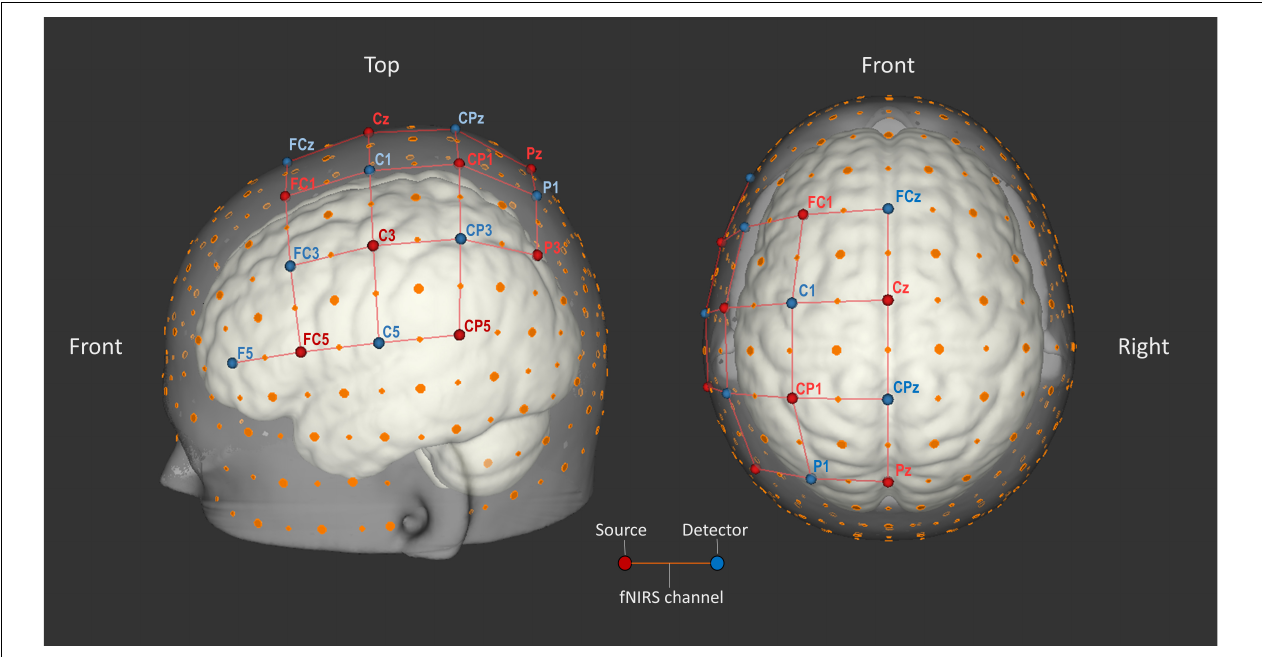
FIGURE 3 | Optode layout. Eight source (red) and eight detector (blue) optodes were placed on 16 points according to the international 10–20 EEG system. Large orange dots represent reference points of the 10–20 system, whereas small orange dots represent reference points of the extended 10–10 EEG system (Oostenveld and Praamstra, 2001). The red lines represent 23 source-detector pairs (each forming an fNIRS channel). Image created using NIRSite software (v.1; NIRx Medical Technologies;